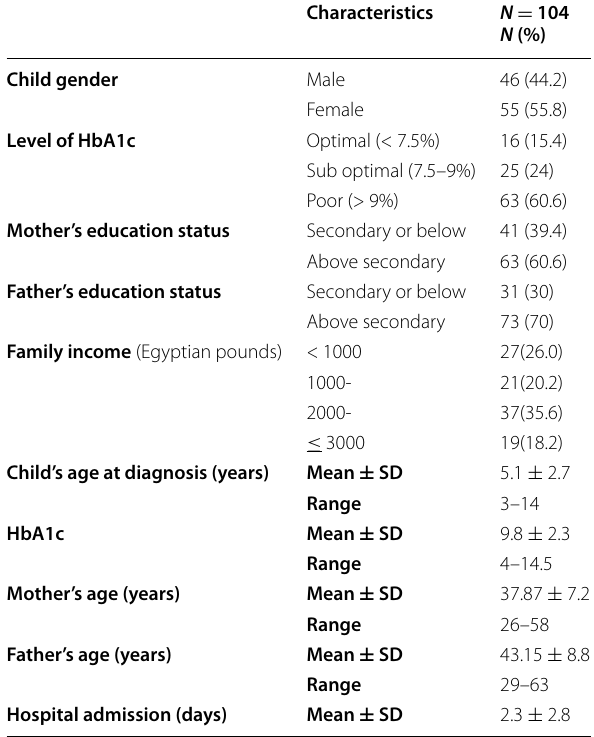
Table 1 Sociodemographic characteristics of diabetic children and their parents as well as clinical characteristics of children